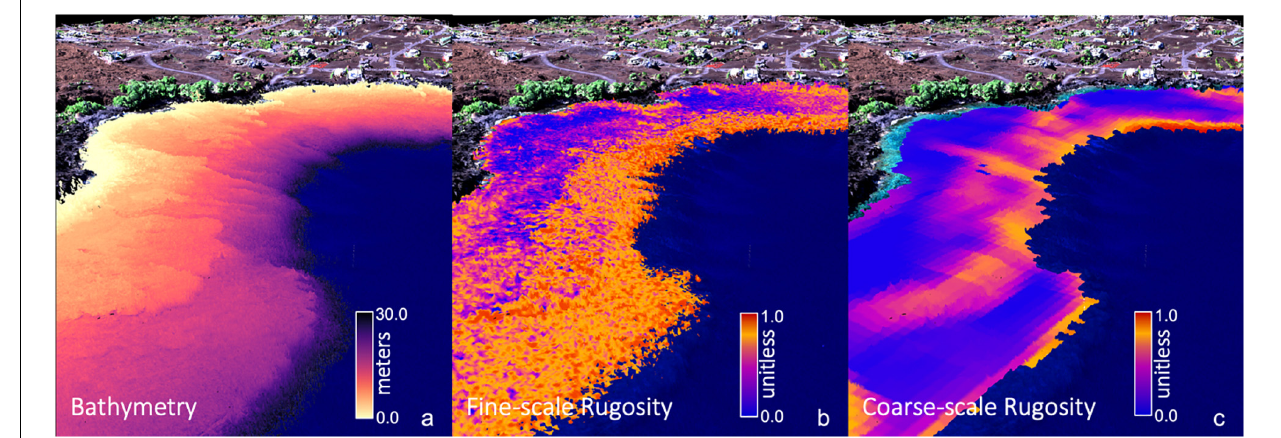
FIGURE 1 | Global Airborne Observatory (GAO) mapping of three-dimensional (a) reef bathymetry, (b) fine-scale rugosity, and (c) coarse-scale rugosity for an embayment along the coast of Hawai‘i Island. Water depth and fine-scale rugosity were mapped at 2 m spatial resolution. Coarse-scale rugosity was mapped at 6 m resolution. Background provides 3D coastline terrain, vegetation and infrastructure as visual